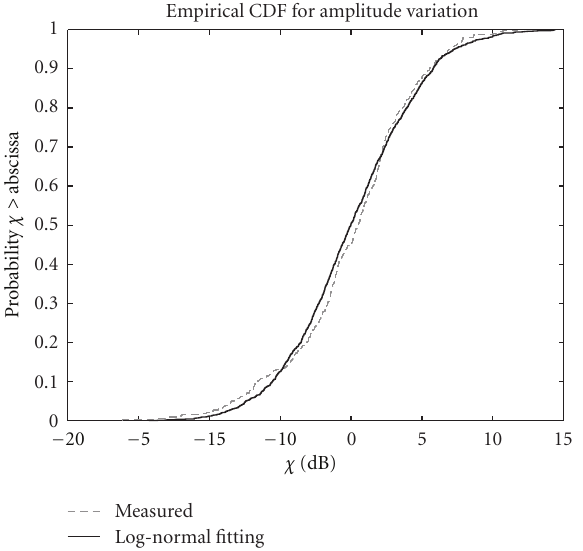
Figure 9: CDFs of the number of paths L for Rx14 (LOS) in the ISM band